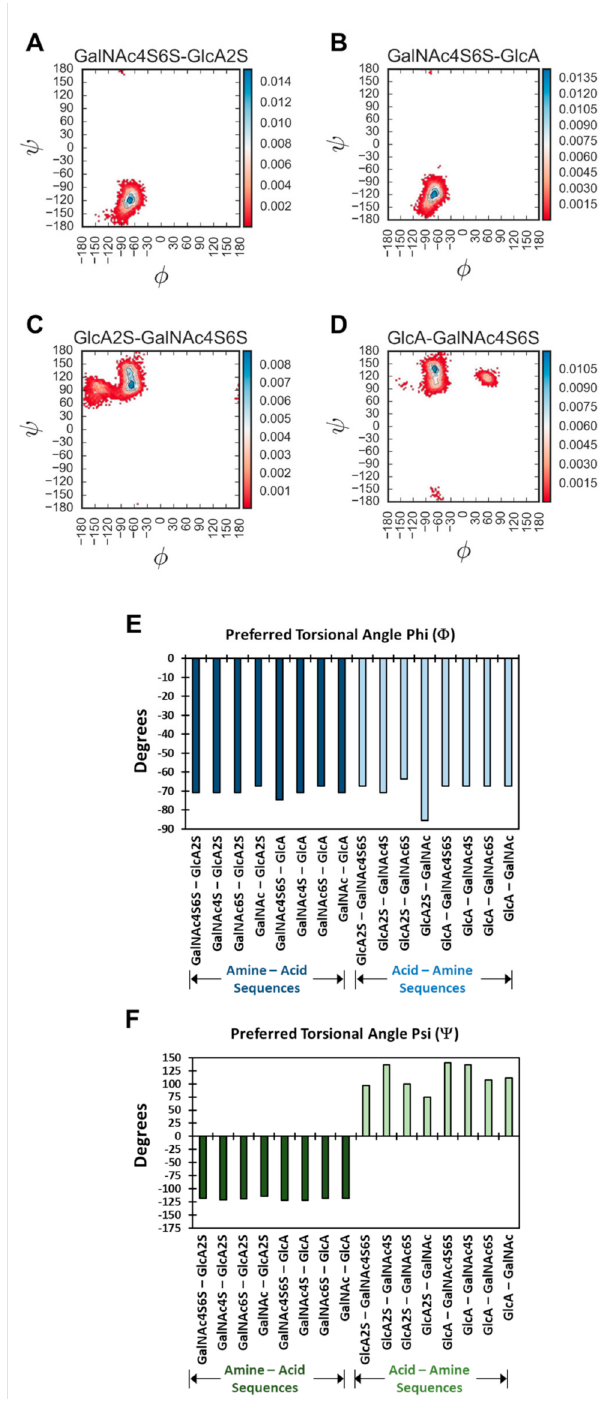
Figure 3. Visualization of torsional populations (phi and psi) within individual bins of identical size (3.6 Å 2 ). ( A – D ) shows representative disaccharides from the group of 16 (see Figures S7 and S8 for others). The contours shown in the Ramachandran plots refer to probability densities with the blue corresponding to higher probability, while red refers to lower density. ( E , F ) present the preferred torsional angles of each disaccharide, which were derived from the high-density regions of corresponding torsional population plots. The probability density plot could be used to identify the preferred torsional angle(s), which corresponded to maximum probability bin(s). As a group, the variation in the